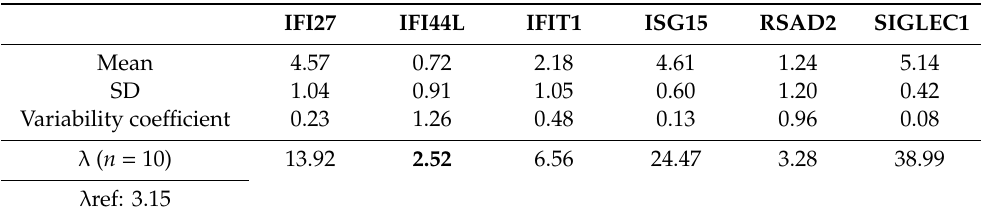
Table 2. Variability assessment for interferon-stimulated genes (ISGs) expression values quantified in ten out of eleven healthy subjects from Dataset A by qPCR.